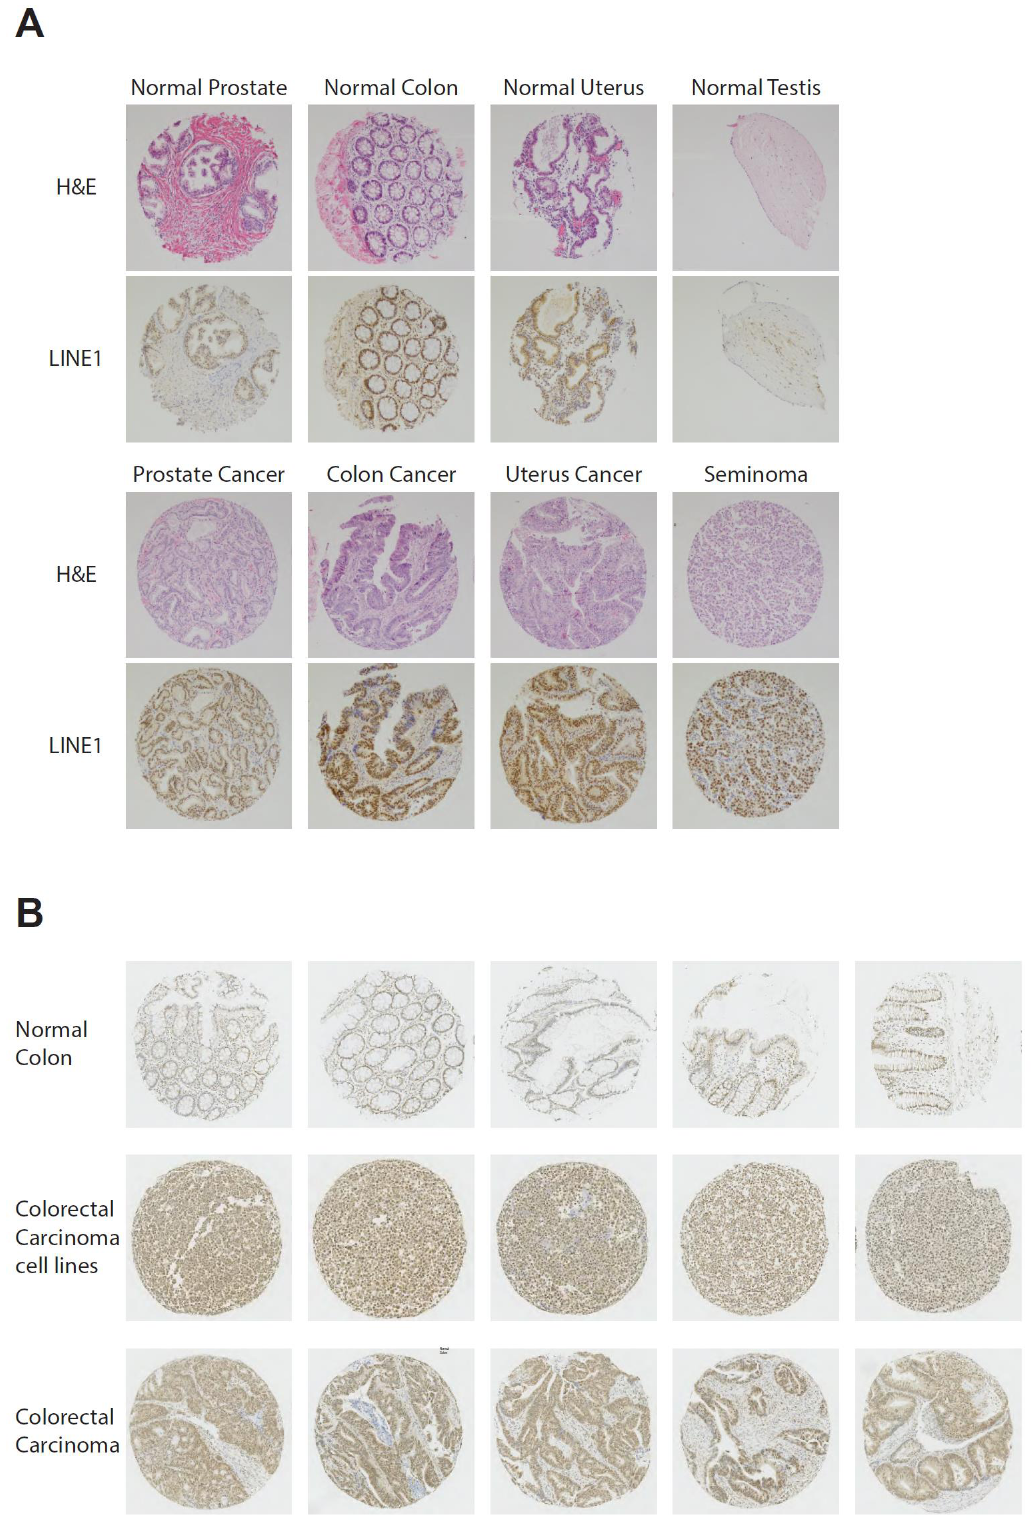
Figure 1. ( A ) Exemplary pictures of H&E and LINE1 immunohistochemical staining of normal tissues and malignant tumors, including prostate, colon, uterus and testis. ( B ) Exemplary immunohistochemistry of normal colonic tissue compared to colorectal carcinoma (CRC) cell lines and tissues of patients CRC. Note the increased LINE1 staining in all malignant tissue. All pictures taken at 10× magnification.